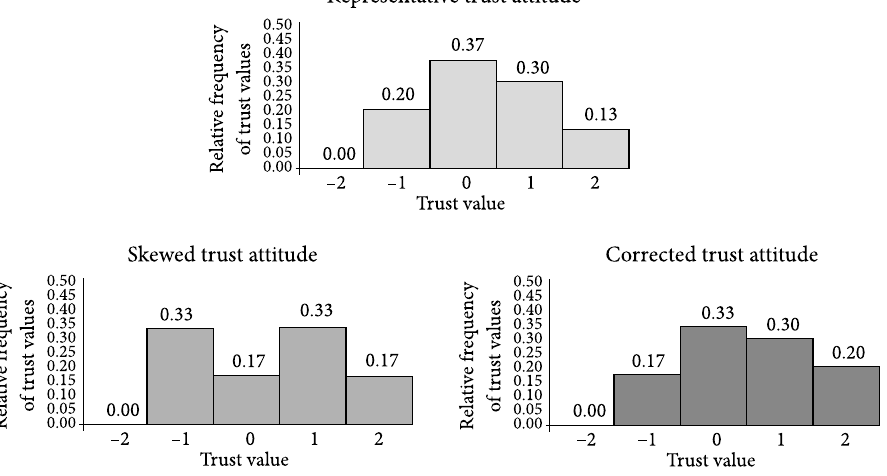
Fig. 2. An agent’s representative, skewed and corrected trust